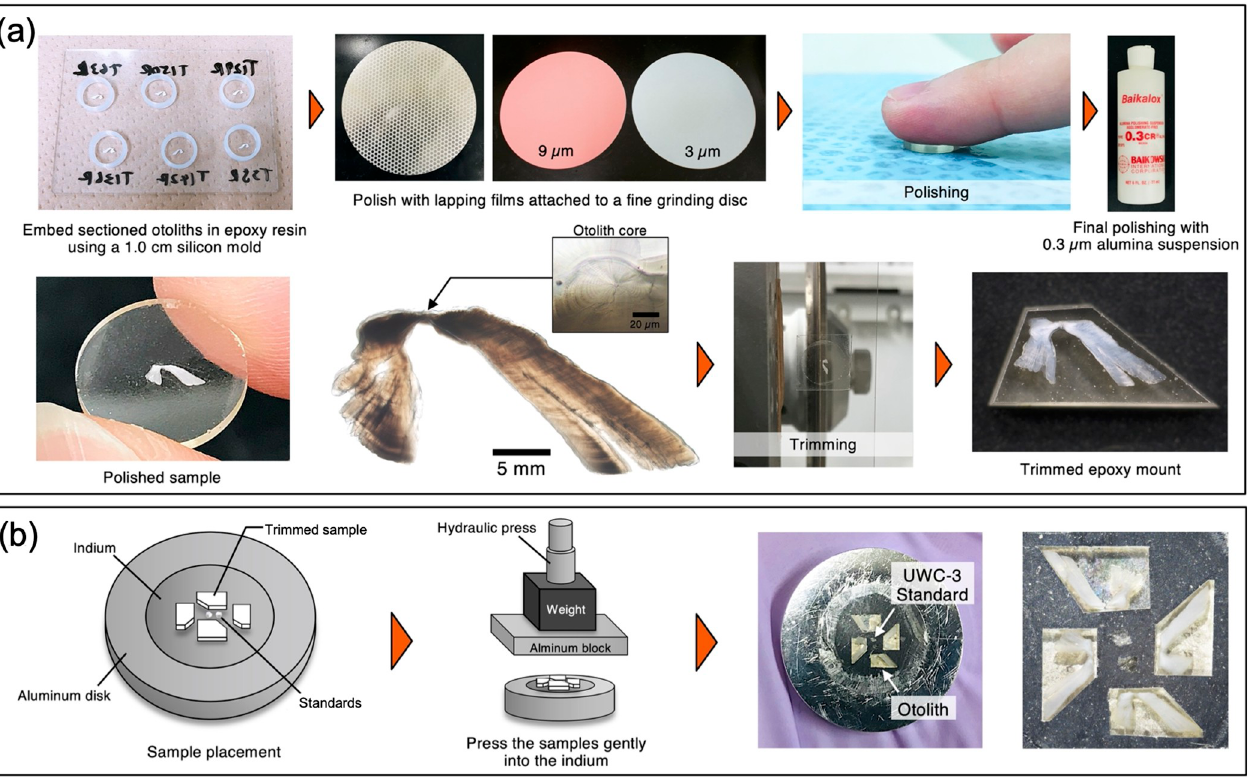
Fig 2. Otolith sample preparation method using indium mount for SIMS δ 18 O analysis. (a) Sectioned otoliths are embedded in epoxy resin using a 1 cm silicon mold. The back of the sample surface (non-sample side) is first ground with a grinding machine to a thickness of approximately 1.5 mm. The sample surface is then polished with 9 and 3 μ m lapping film, followed by a final polishing with 0.3 alumina suspension. Finally, the excess epoxy resin around the otolith is trimmed off. (b) Two pieces of pre-polished UWC-3 standards are pressed into the center of an indium mount with a clean plastic. Samples are placed within a 1 cm diameter circle of the mount and then gently pressed into the indium using a hydraulic hand press. Pressing process should be done in a repeated manner with a force of 0.2 to 0.3 kN until the otoliths are fully embedded, and then the final press is done with 10